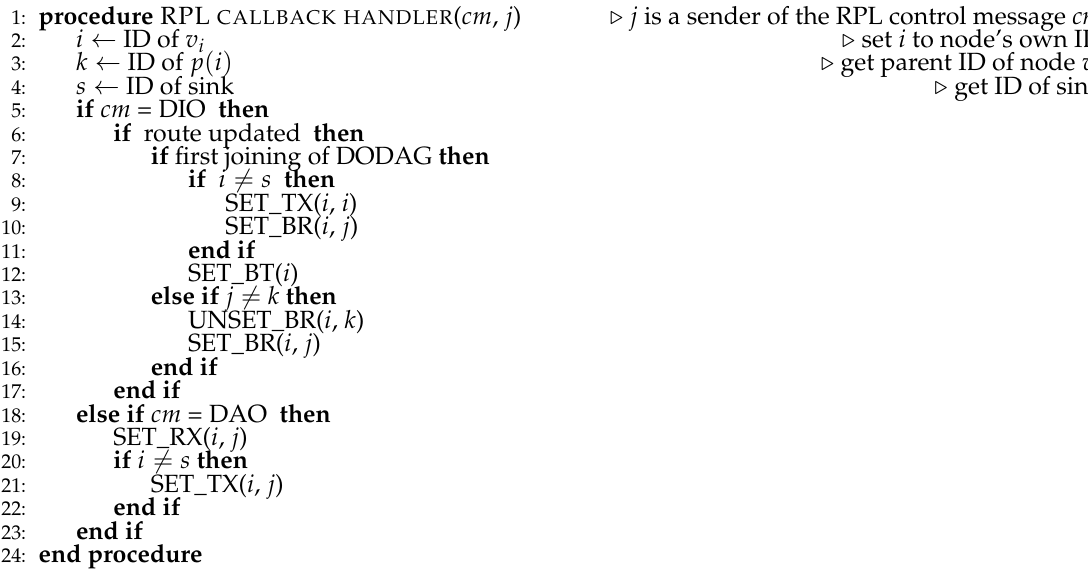
Algorithm 1 RPL callback handler for timeslot